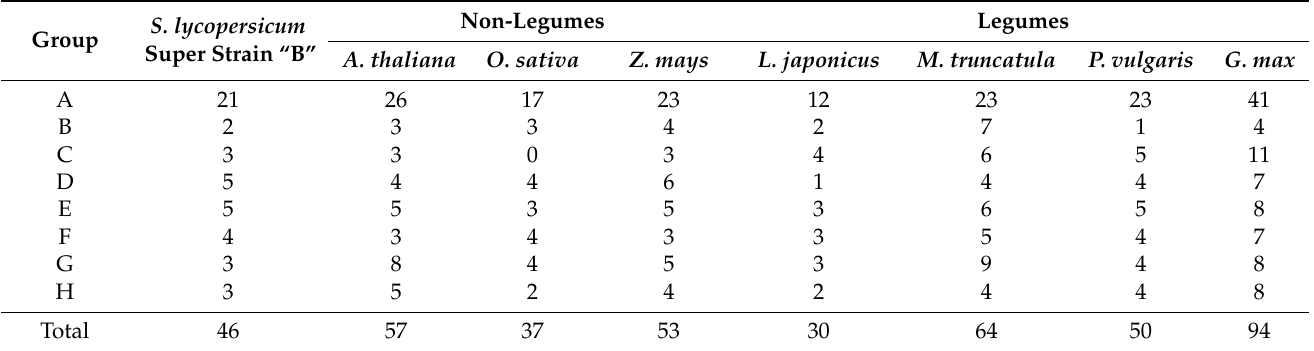
Table 2. Number of the small GTPases Rab subfamily members expressed in Solanum lycopersicum super strain “B” compared with some non-leguminous and leguminous plants retrieved from the data